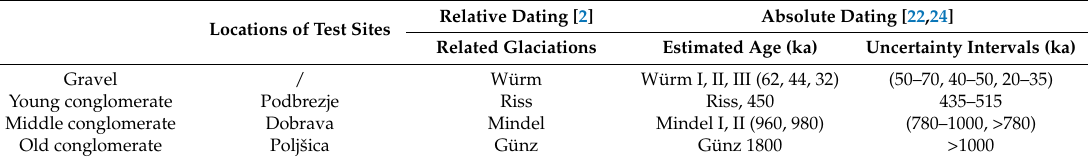
Table 1. The relative and absolute dating methods and inferred ages for the three study sites. The names of glaciations are used as morphostratigraphic and not chronostratigraphic